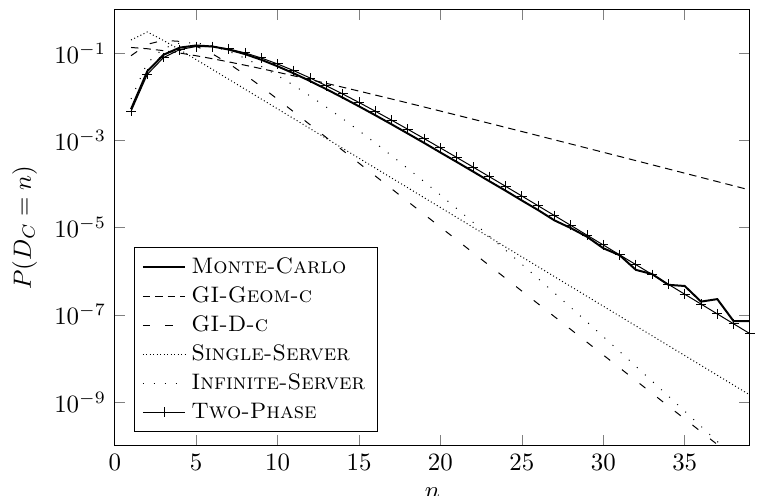
Figure 5. Probability mass function of the customer delay for a 5-server system with Poisson arrivals, shifted negative-binomial service demands with 5 phases and mean τ = 50, and negative- binomial service capacities with 5 phases and mean µ = 10, with load ρ = 0.7, as estimated by various approximations.